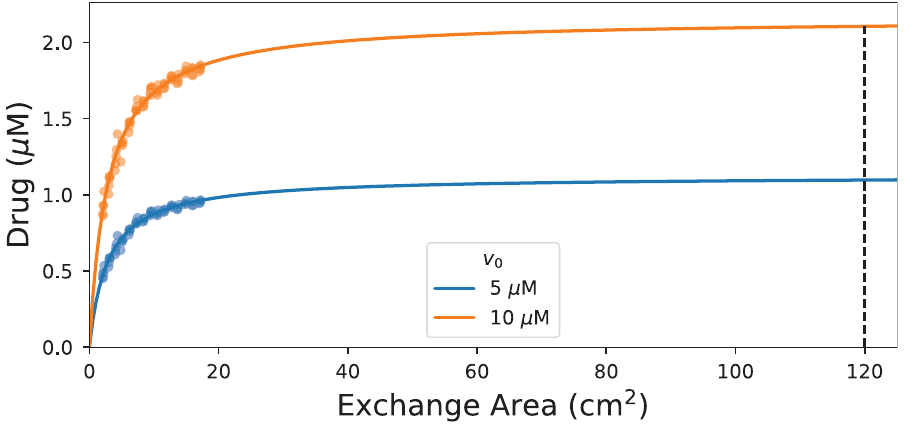
Fig 6. The total drug concentration at steady state as a function of the exchange area with the best fit to Eq (5). The drug concentration in the incoming blood is v 0 = 5 μ M and v 0 = 10 μ M, respectively. The dashed vertical indicates the extrapolated value for the estimated exchange area of 120 cm 2